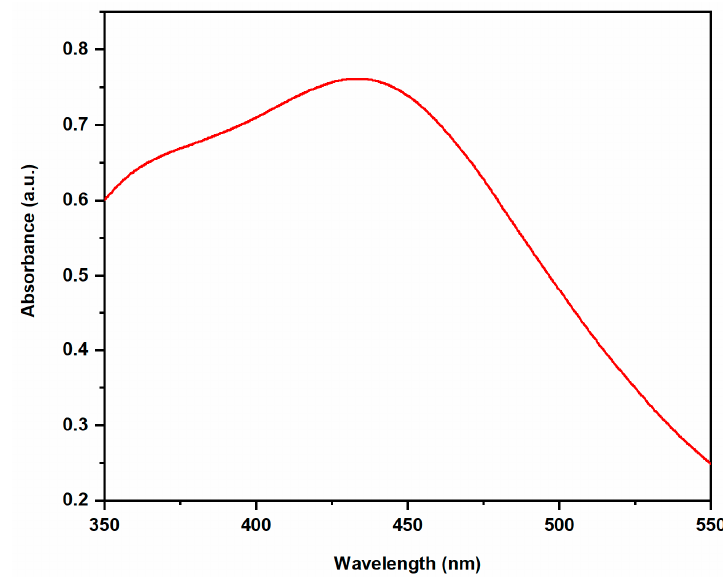
Figure 2. UV–Vis absorption spectrum of the biosynthesized AgNPs.